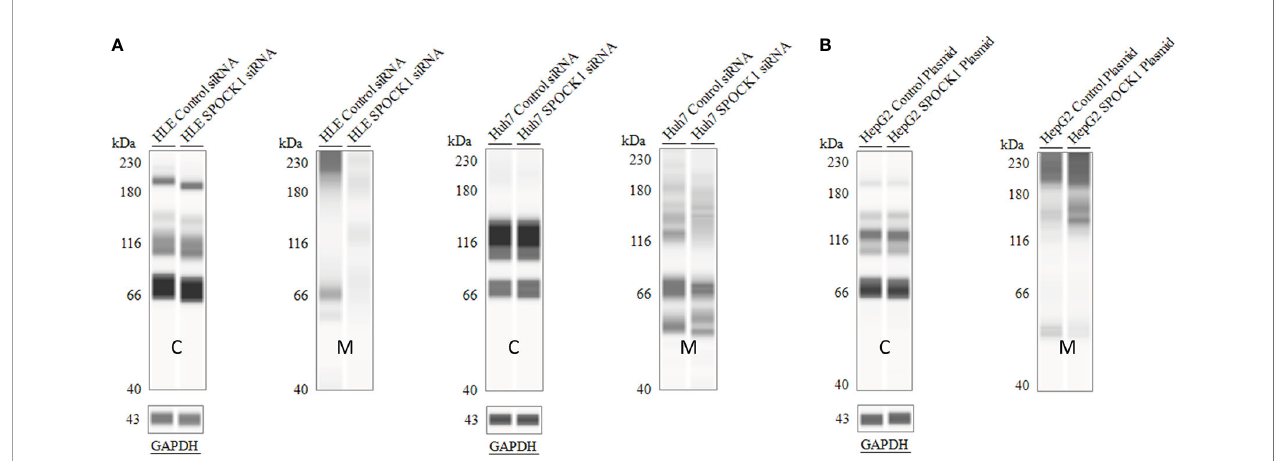
FIGURE 11 | SPOCK1 downregulation and upregulation were mirrored only by the amount of the secreted proteoglycan. WES of SPOCK1-silenced (A) and SPOCK1-transfected (B) cells were separated and run parallel with the part of the proteins secreted into the culture medium. The intracellular concentration of the protein remained constant, and only the amounts secreted to the medium represented the changes. C, tumor cells; M, culture medium.